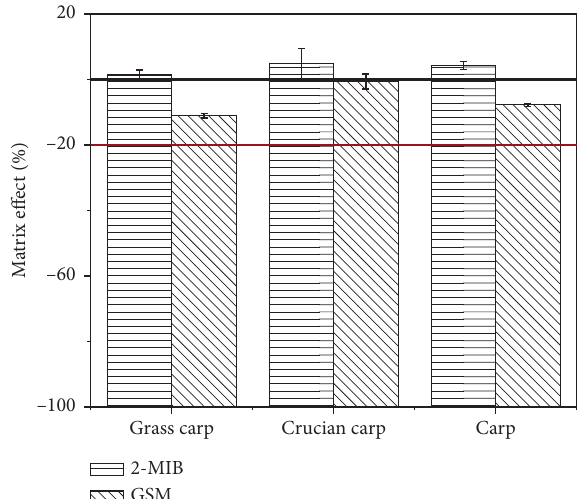
Figure 4: Matrix effect of 2-MIB and GSM in the reconstitution solution obtained from grass carp, crucian carp, and carp undergoing extraction and cleaning